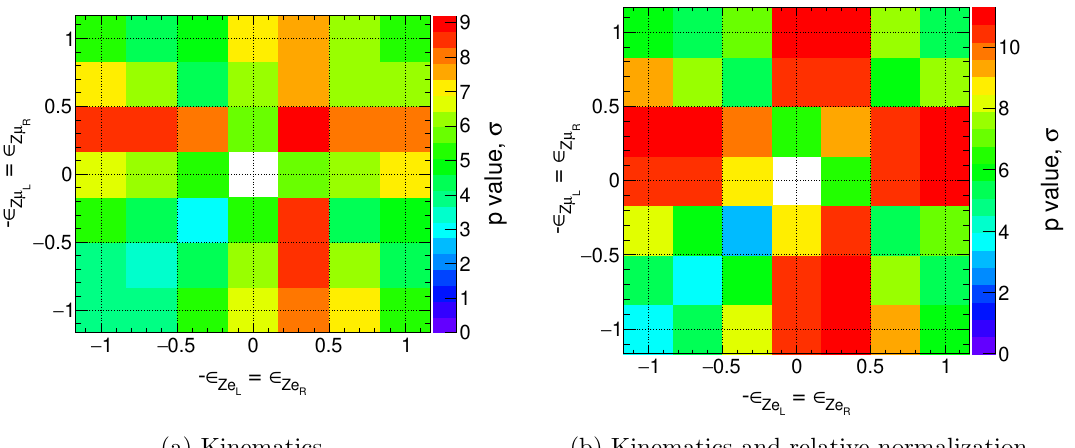
Figure 4. This (cid:12)gure is the same as (cid:12)gure 2a, except that here we are considering scenario 6, in which the anomalous PO are (cid:15) Ze